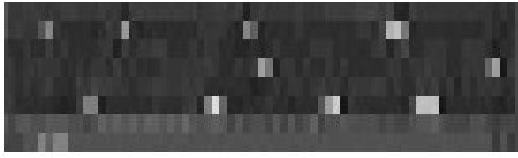
Figure 9: Region of Interest for Vehicle